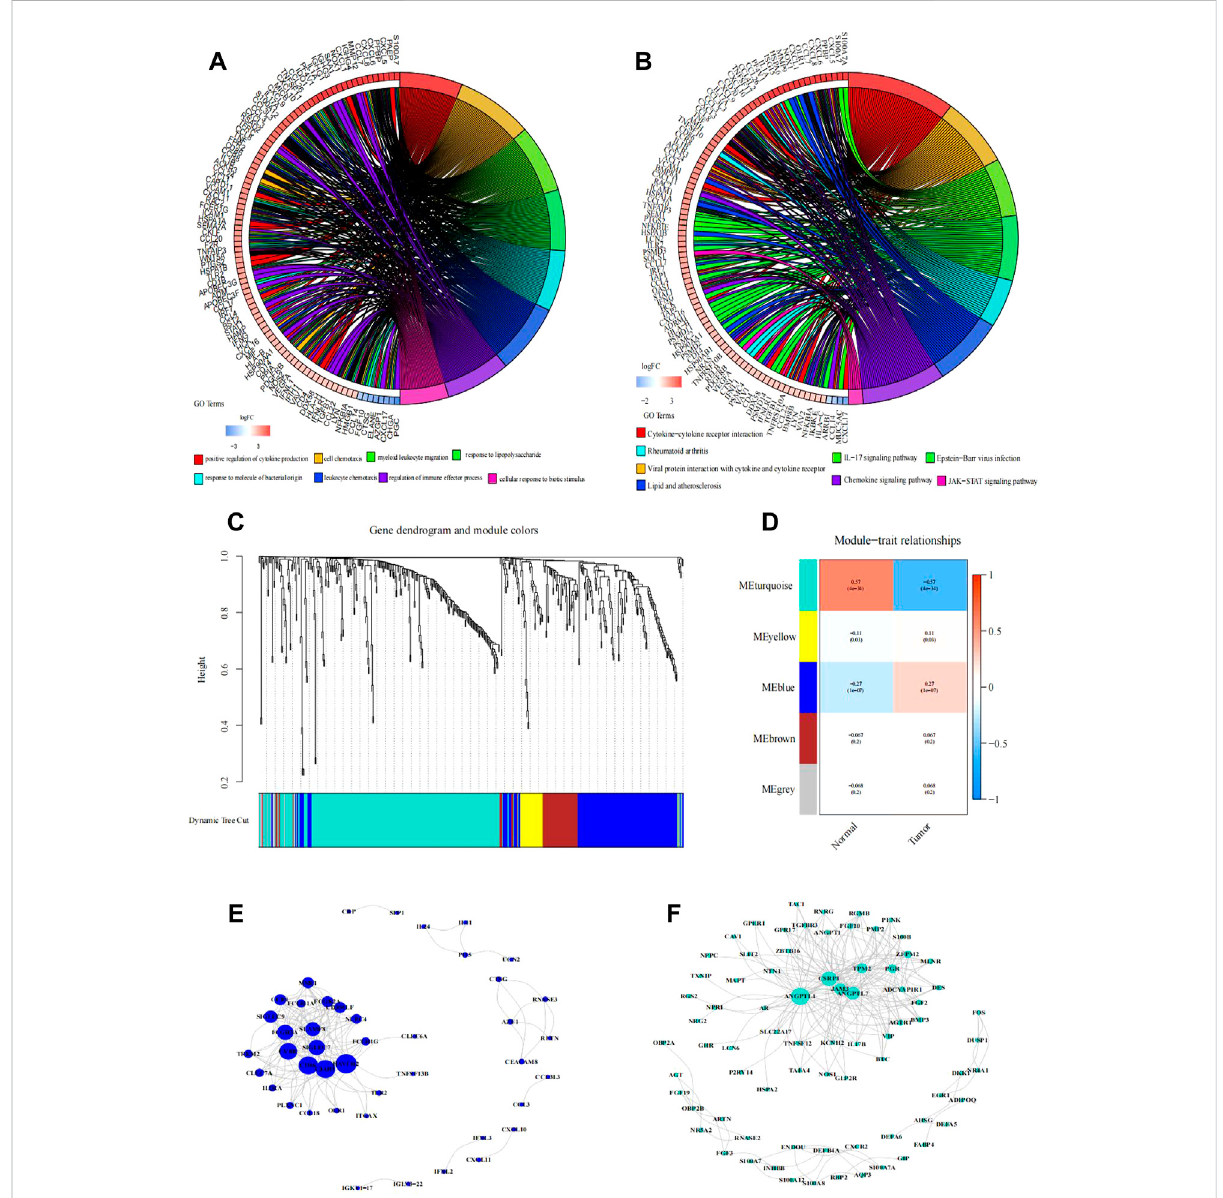
Figure 3G. The ROC – AUC for 1-year OS prediction had the best performance . Additionally, our IRGPI model obtained better predictive power than the TIDE and TIS scores (Figure